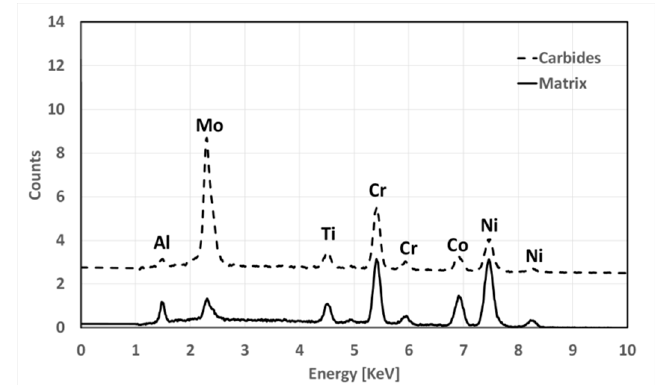
Figure 11. Electron Dispersive X-Ray Spectroscopy (EDS) spectra comparing the matrix (black line) and Mo carbides (dotted line) located at grain boundaries and inside grains. Table 3. Evolution of fraction of area occupied by carbides and their average diameter in LT samples from solutioning to second aging.